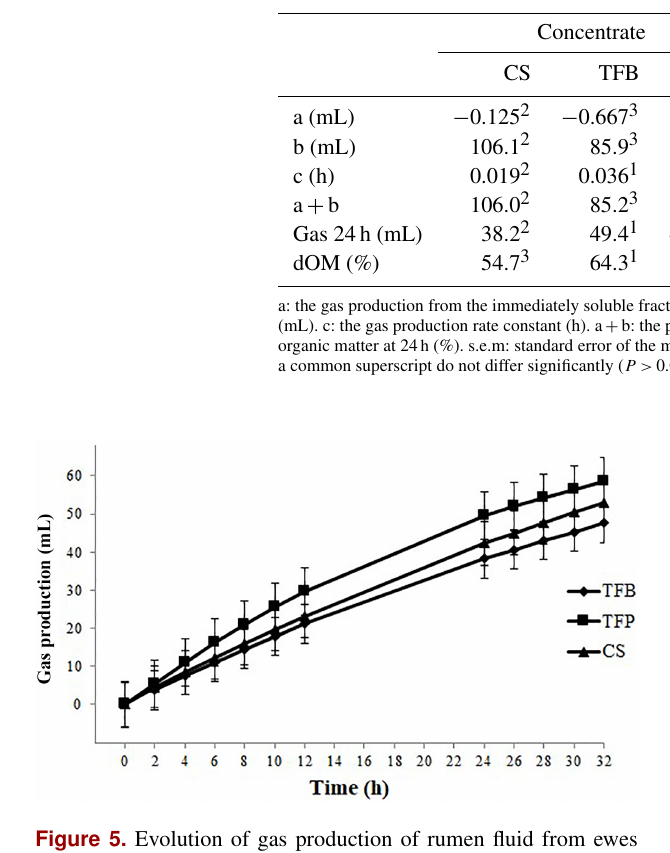
Figure 5. Evolution of gas production of rumen fluid from ewes fed through incubation according to the type of concentrate fed in the experimental diets (1.8kgd − 1 of oat hay + 500gd − 1 of con-